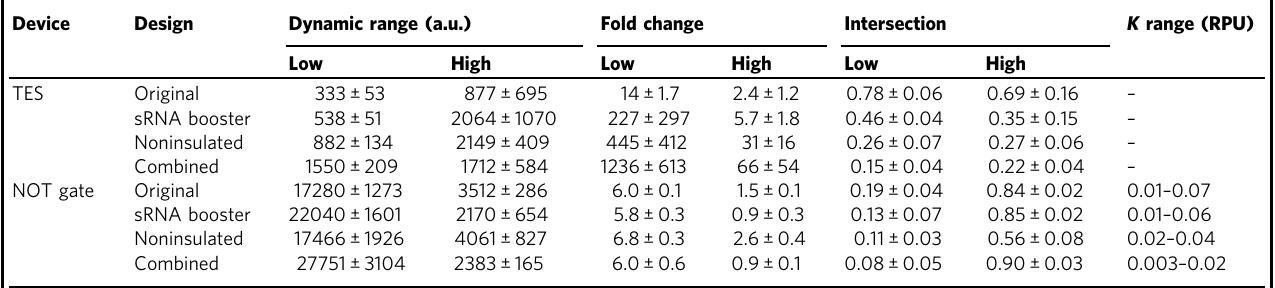
Table 1 Performance summary of TES and tunable NOT gate.